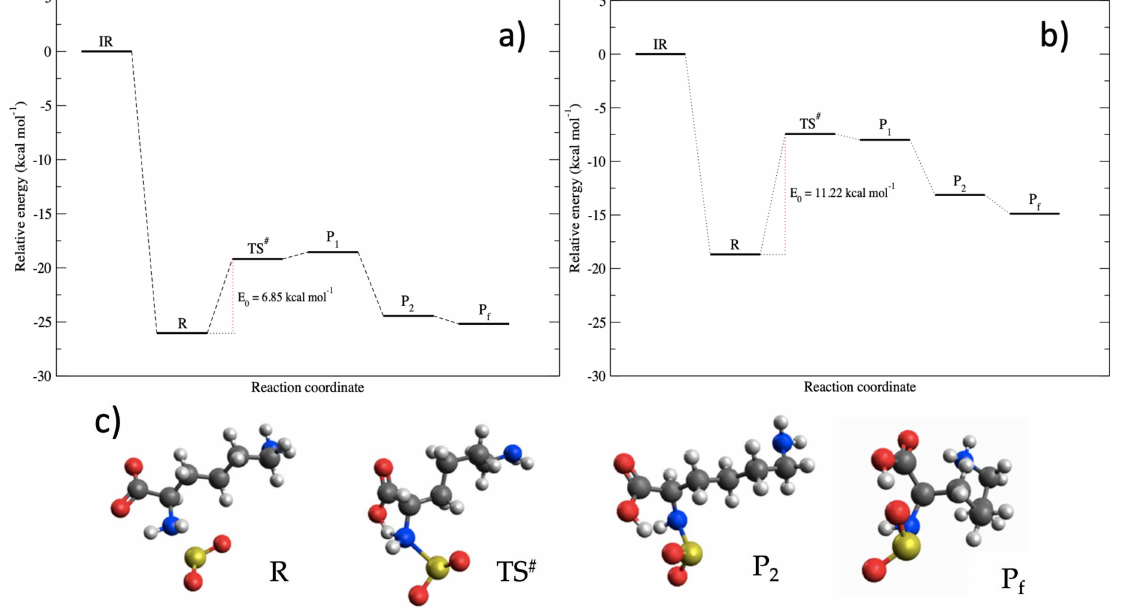
Figure 7. Reaction energies of the Lys-TS5 path with respect to isolated reactants as computed using zero-point energy-corrected electronic energies. ( a ): Reaction in the gas phase. ( b ): Reaction in the SMD solvent model. ( c ): Optimized geometries in the gas phase of the stationary points along the reaction path. The P 1 product is a high-energy isomer of P 2